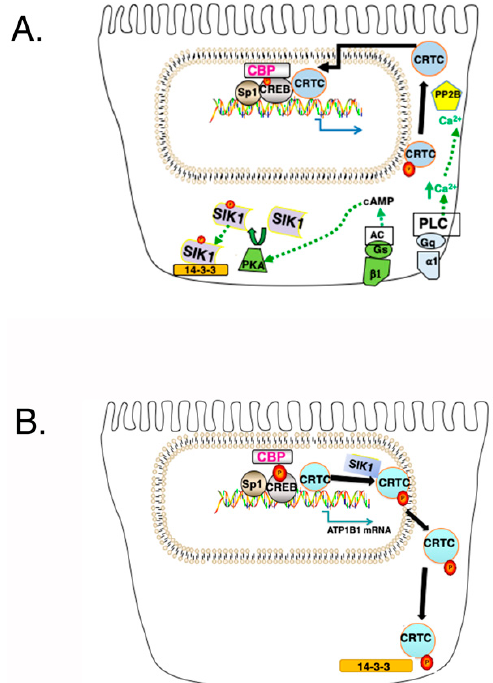
Figure 4. Establishment of a CREB / CRTC Interaction and its Disruption by SIK1. ( A ) Following a simultaneous increase in cAMP and Ca 2 + in , SIK1 is phosphorylated at Thr473 by PKA, which results in an interaction between PKA phosphorylated SIK1 and 14-3-3 proteins (which results in the sequestration of SIK1 in the cytoplasm, and which prevents the further phosphorylation of CRTCs by SIK1). CRTCs, which are phosphorylated (at Ser151 in the case of human CRTC1), are dephosphorylated by Calcineurin (i.e., Protein Phosphatase 2B (PP2B)). As a consequence, CRTCs translocate to the nucleus and interact with CREB, causing an increase in transcription, beyond that obtained with the Ser-133-pCREB / CBP interaction. ( B ) Following SIK1 activation (and its dephosphorylation at the PKA phosphorylation site), SIK1 no longer interacts with 14-3-3 proteins, which permits the nuclear translocation of SIK1. Once in the nucleus, SIK1 phosphorylates CRTCs, which translocate to the cytoplasm.